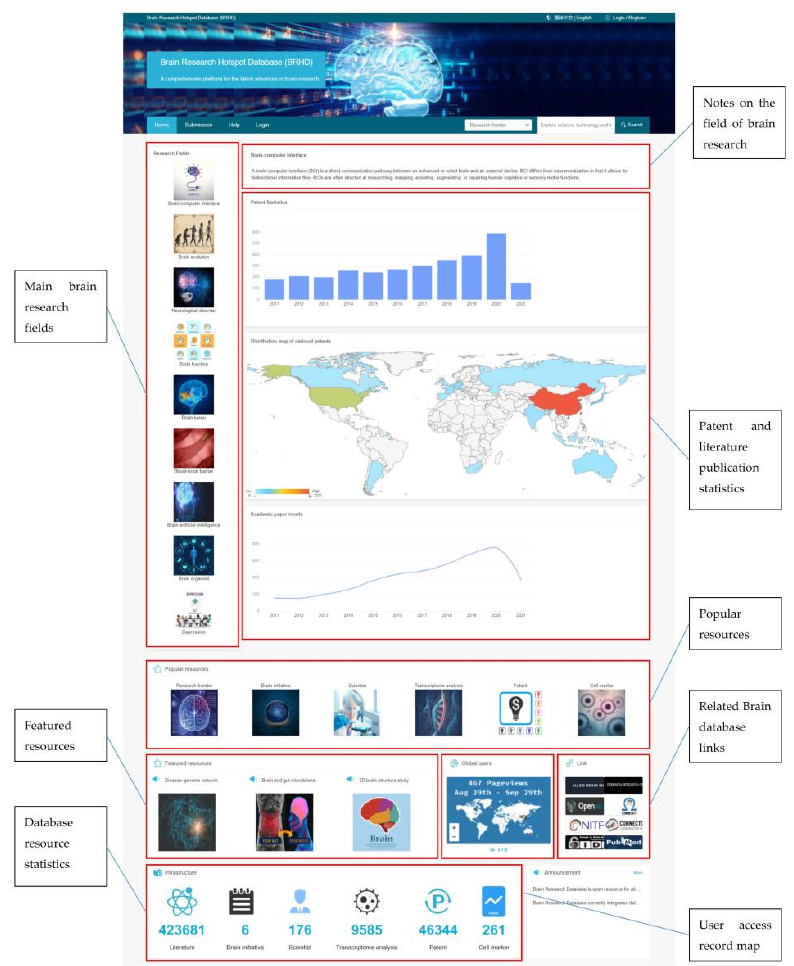
Figure 9. Introduction of each part of the BRHD main